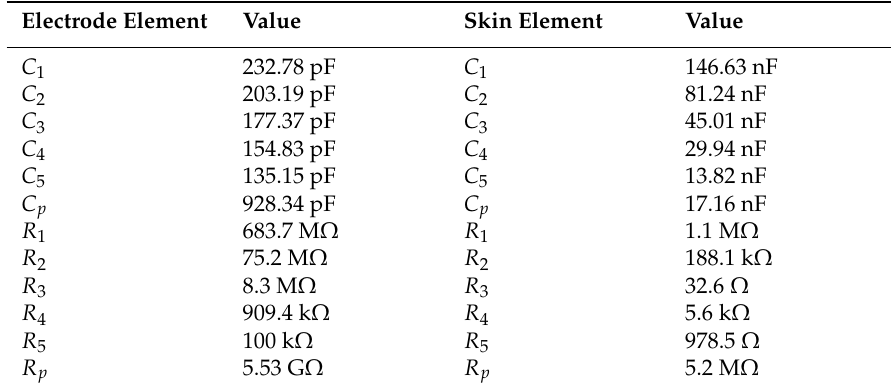
Table 3. Passive element values for approximating the fractional-order